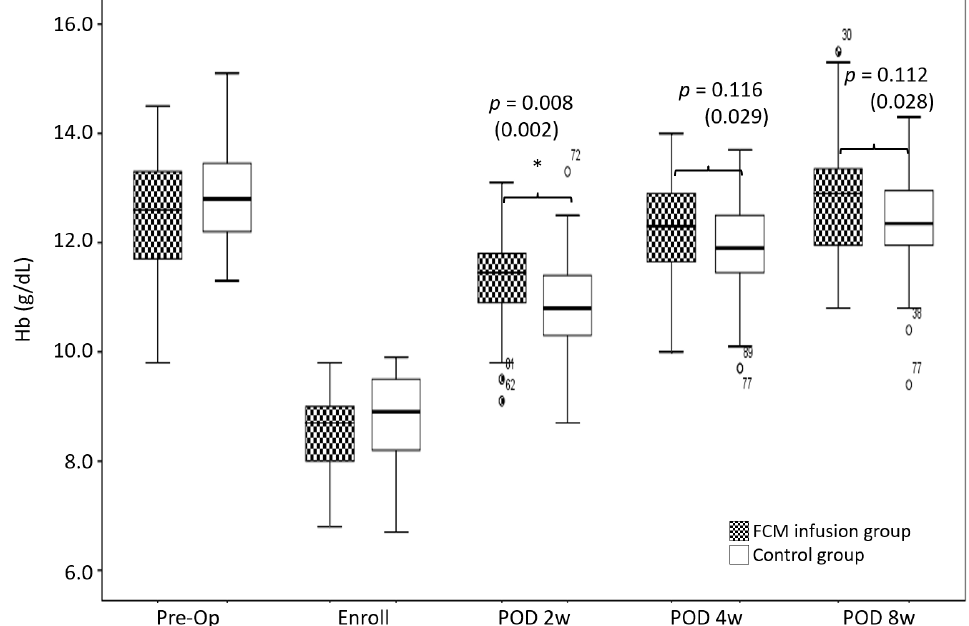
Figure 2. Comparisons of the Hb level between the FCM and Control groups. The asterisks demonstrate a significant difference between groups. Band within the box = median; top and bottom of box = interquartile range (IQR); whiskers = values within 1.5 IQR of the top or bottom of the box; black and white circles with number = outliers in FCM group with case number indicating the case number; and white circles with number = outliers in Control group with case number indicating the case number. The p -values corrected by Bonferroni analysis are indicated, with the p -values before the Bonferroni analysis in parentheses. Hb: hemoglobin; FCM: ferric carboxymaltose; Pre-op: